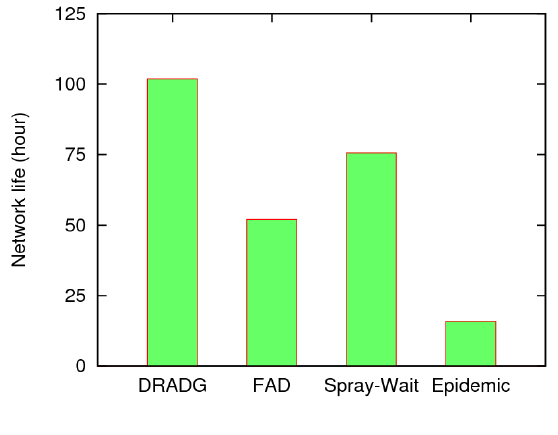
Figure 8. The network life under scenario